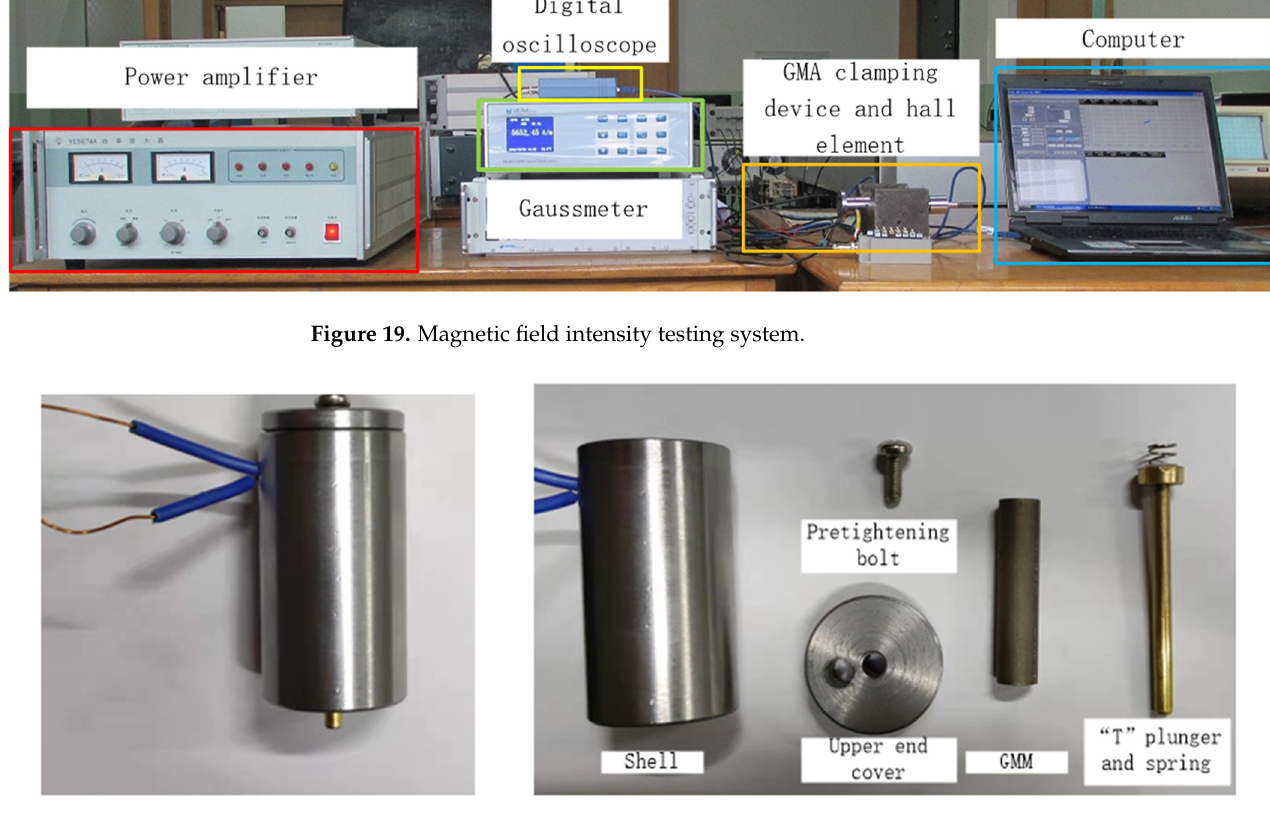
Figure 21. Magnetic field intensity measuring point. 3.2.2. Comparison between Simulation Results and Experimental Results Preheat Hall probe and Gaussmeter were used for 5 min and 30 min, respectively. Sinusoidal alternating current with an amplitude of 2A and frequency of 25 HZ was in- putted, and measurements were taken. During measurement, GMA was clamped with clamping fittings, restricting the movement of the Hall probe by fixing the device; the distance from the end of GMA to the end of the Hall probe was then measured with a vernier caliper, so as to realize the accurate positioning of measuring points, as shown in Figure 22.